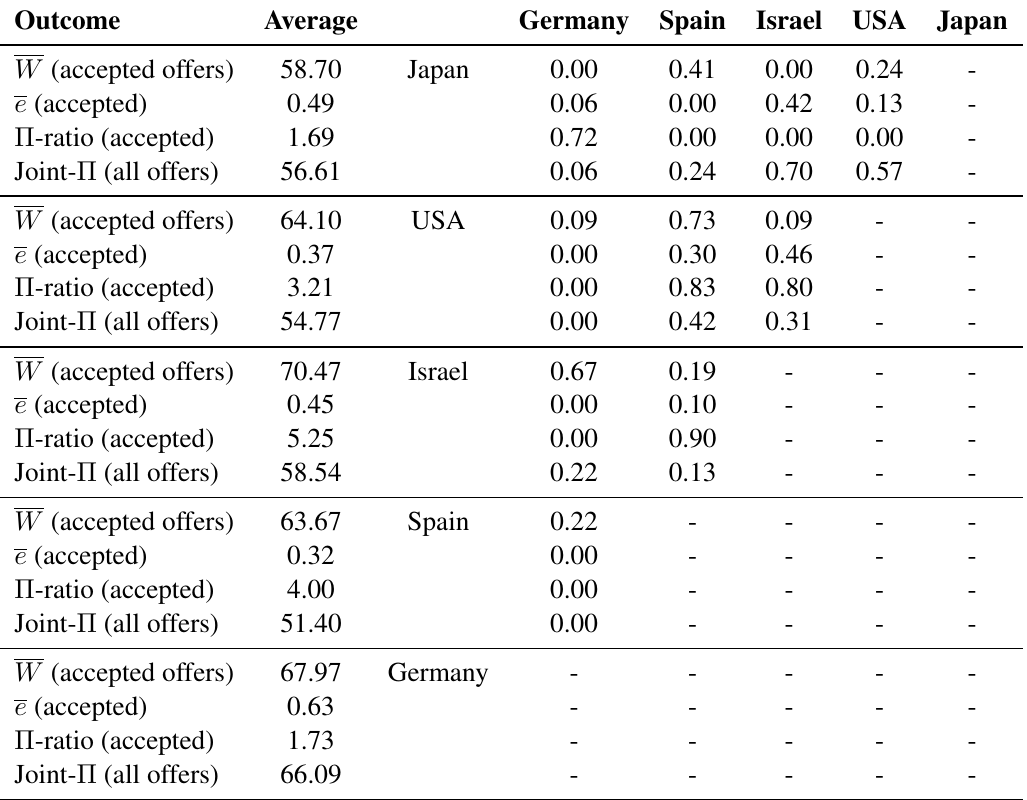
Table B2. Statistical differences across fixed-matching treatments.